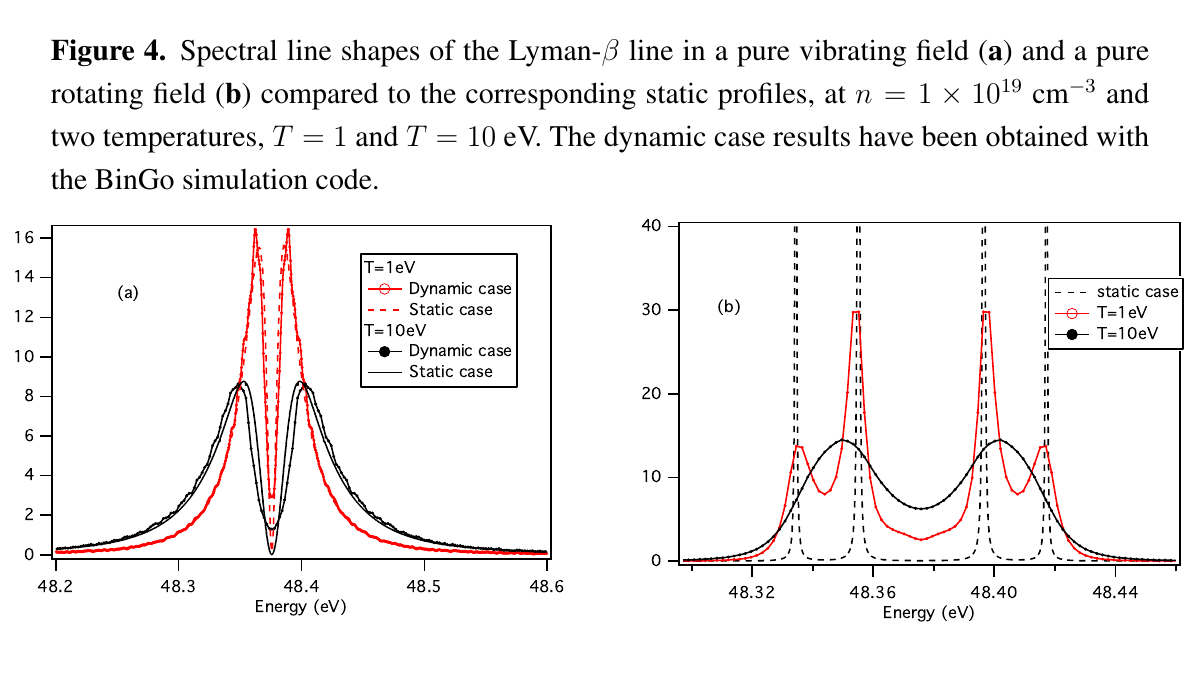
Figure 5. Reduced-mass effect on the Lyman- α line shape at n = 10 18 cm − 3 and T = 10 eV in the three models of field (full ( a ); rotation ( b ) and vibration ( c )). The color codes black, red and blue correspond to µ , 4 µ and 16 µ , respectively. The calculations have been done 0 0 0 with the SimU simulation